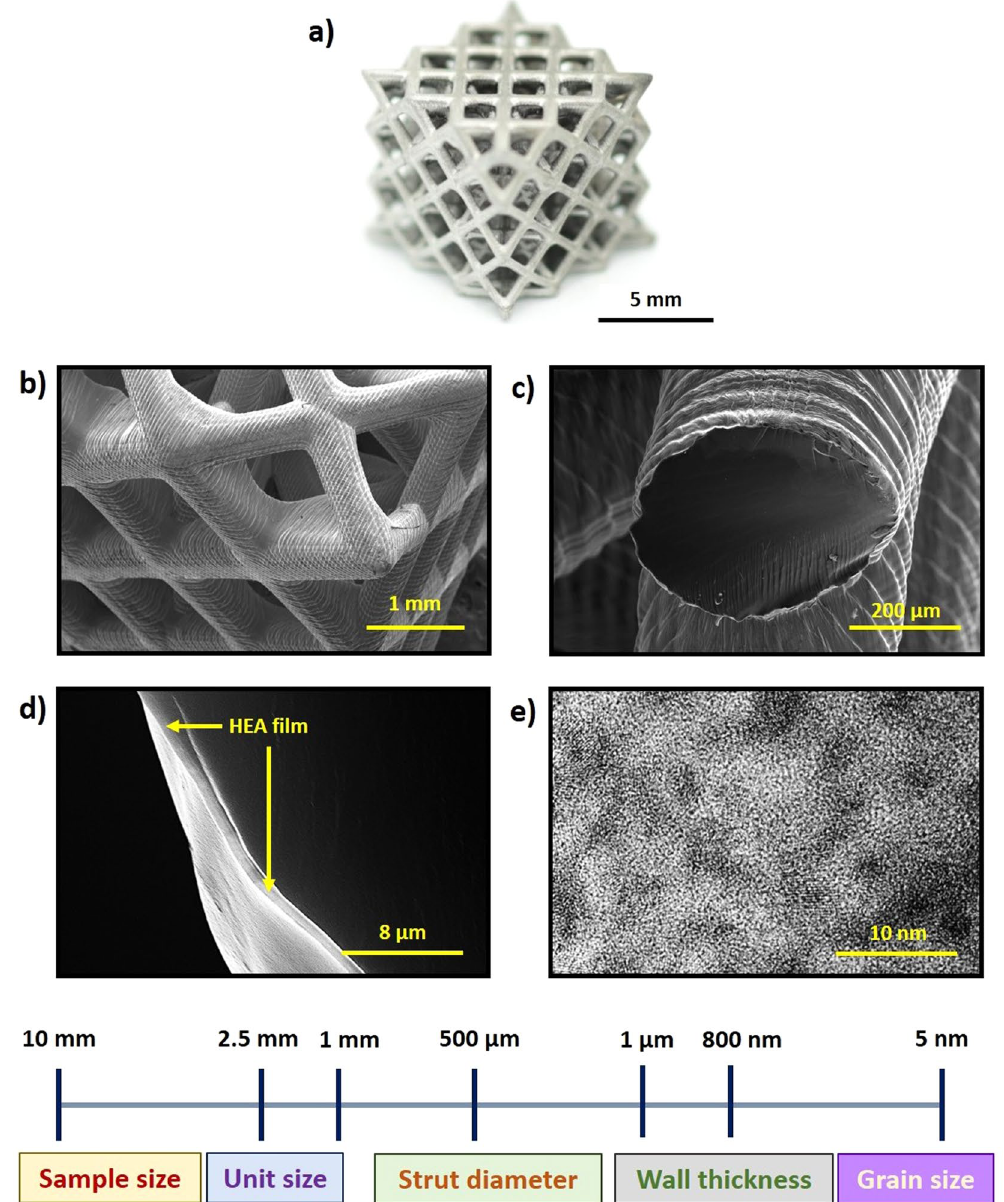
Figure 3. Hierarchical structure of the core-shell microlattice, showing structural features spanning from 5 nm to 75 mm. ( a ) Pure polymer microlattice template. ( b ) HEA-coated microlattice unit. ( c ) A single HEA-coated strut ~450 µ m diameter. ( e ) Fractured polymer/HEA microlattice showing the thickness of the HEA coating (~800